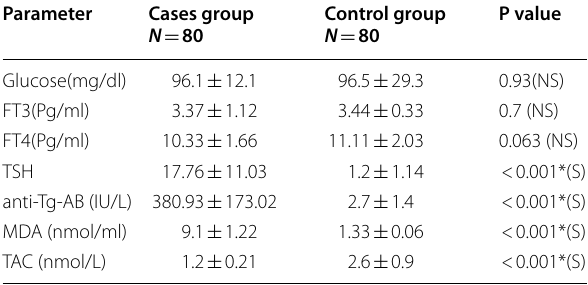
fT 3 (free triiodothyronine), fT 4 (free thyroxine), TSH (thyroid-stimulating hormone, Tg (anti-thyroglobulin antibody), MDA (malondialdehyde), TAC